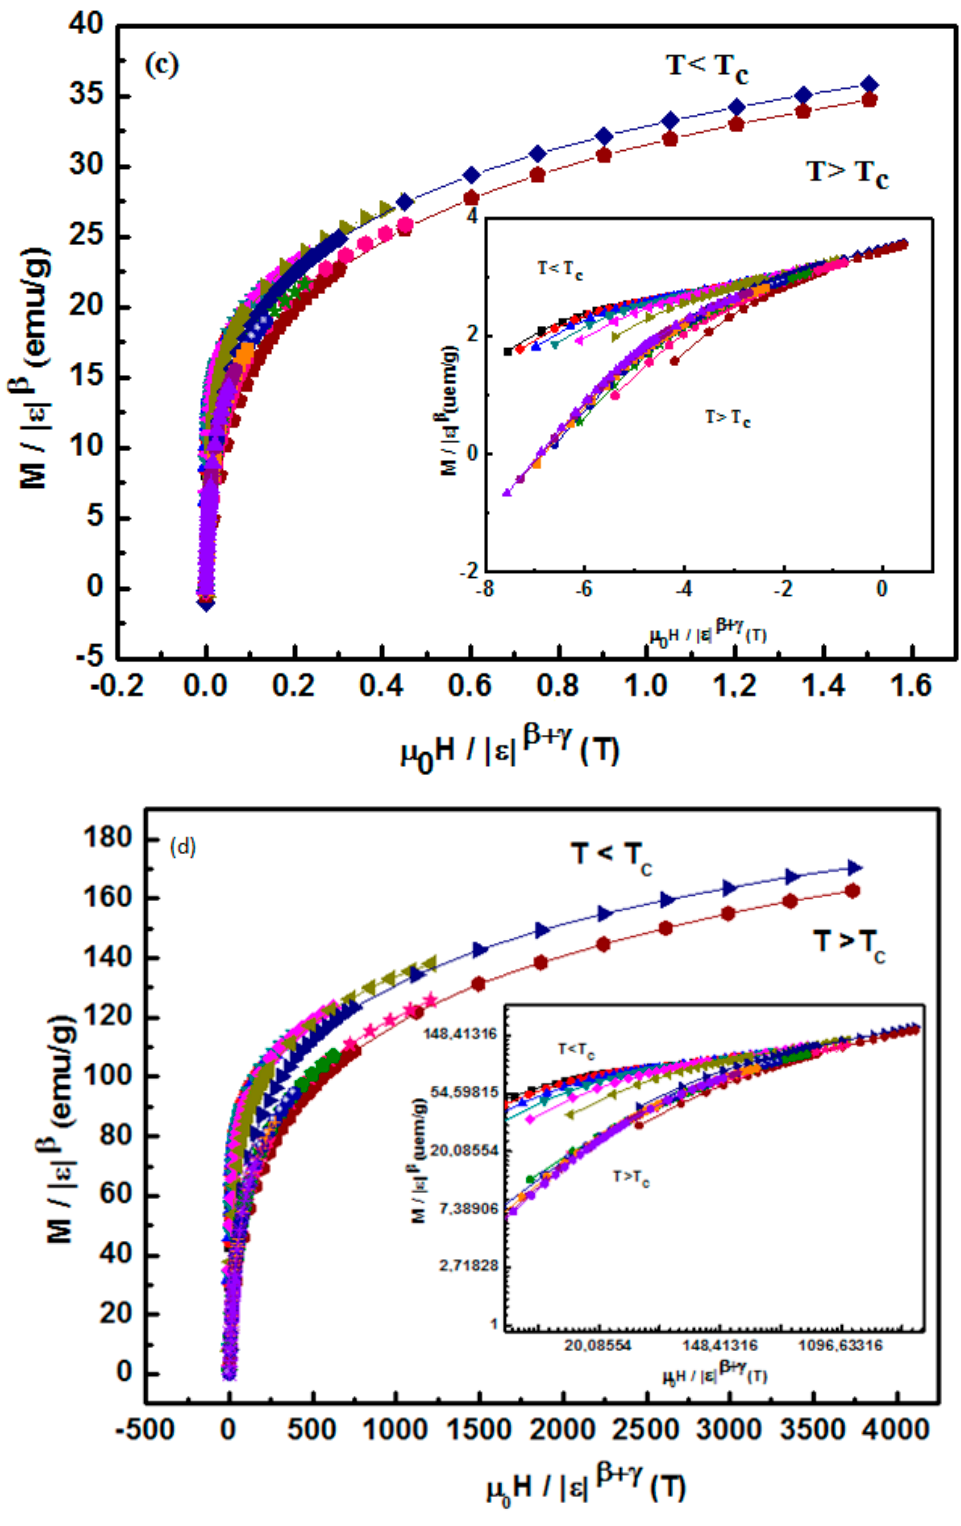
Figure 9. Scaling plots below and above T C using β and γ determined from the modified Arrott plots. The inset shows the same plots on a log-log scale. For La 0.8 Ca 0.2 Mn 1 − x Co x O 3 , ( a ) x = 0.1 with β = 0.204 and γ = 1.969; ( b ) x = 0.1 with β = 0.123 and γ = 1.3516; ( c ) x = 0.2; and ( d ) x = 0.3. The field dependence of the entropy change related to the local exponent n has been analyzed using the results of magnetic entropy change. Indeed, according to Oesterreicher et al. [24], the field